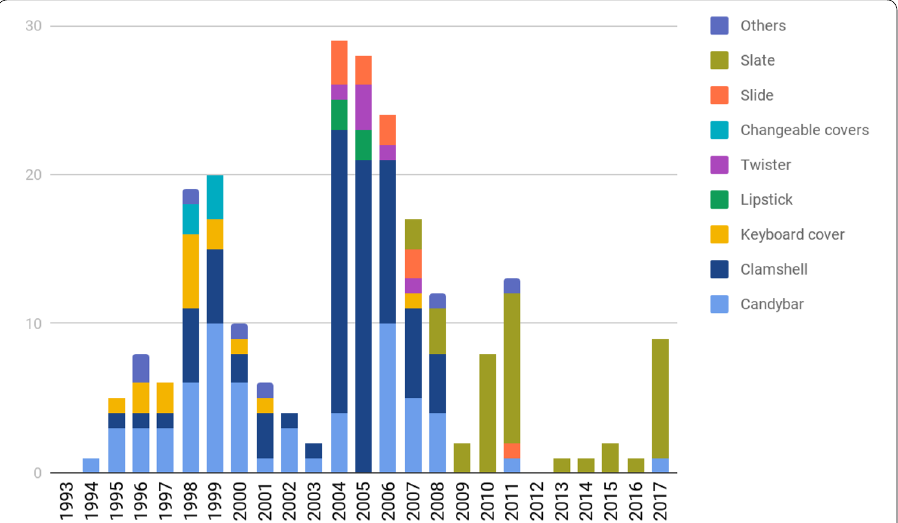
Fig. 2 The changing forms of mobile phones in fashion magazines between 1993 and